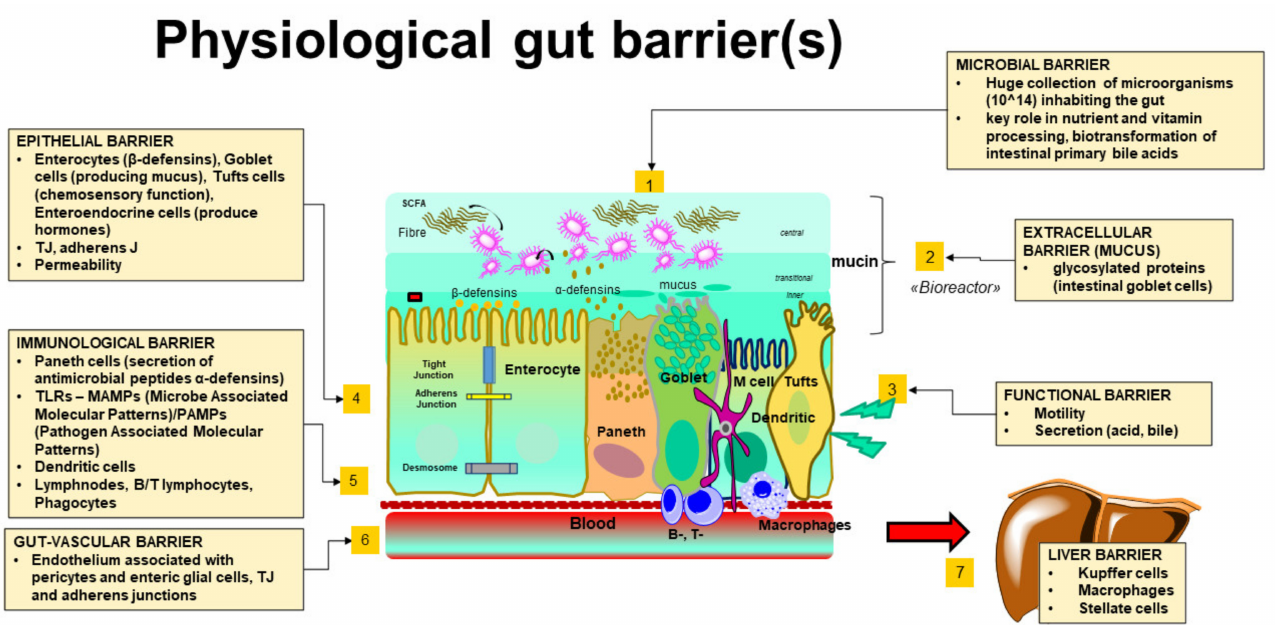
Figure 1. The integrated components of the intestinal barrier in physiological conditions: (1) the gut microbiota (i.e., microbial barrier); (2) the gut mucus, accumulating at the interface between the intestinal lumen and the brush border of enterocytes; (3) the interplay between gastrointestinal motility and secretions (i.e., the functional barrier); (4) the epithelial barrier and the tight junctions; (5) the immune-competent cells and their products (i.e., the immunological barrier); (6) the gut– vascular interface; (7) the hepatic filter (i.e., the liver barrier). Adapted from Di Ciaula et al.